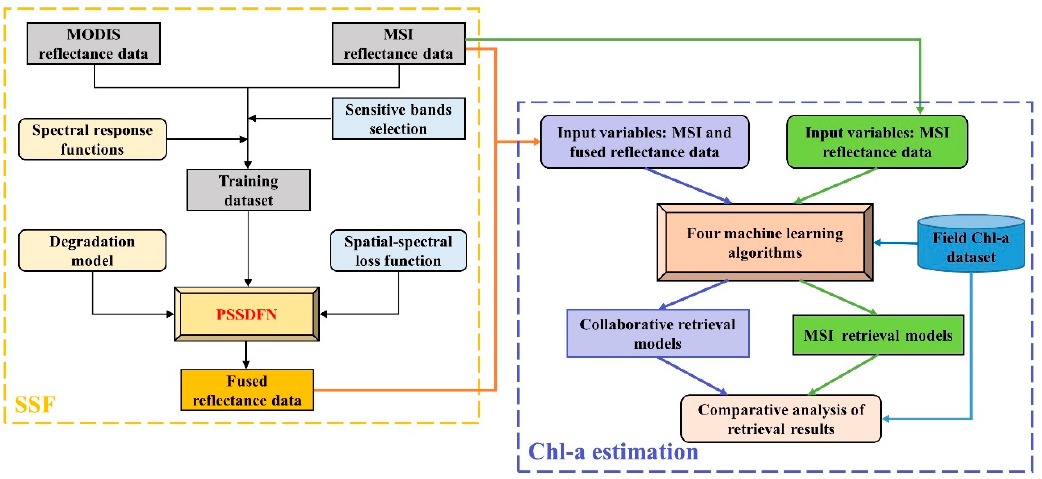
Figure 3. Flowchart depicting the study